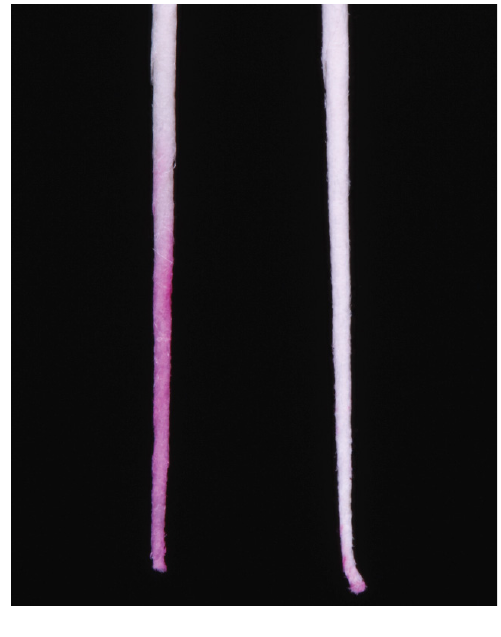
Figure 2. Last paper point used in moist (left) and dry (right)